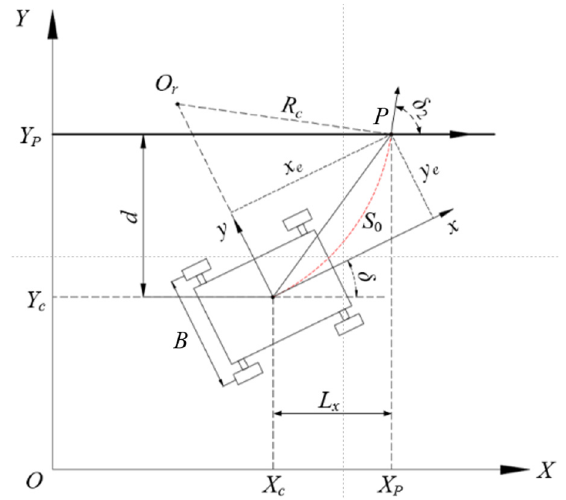
Figure 8. “Preview-follow” path tracking algorithm.